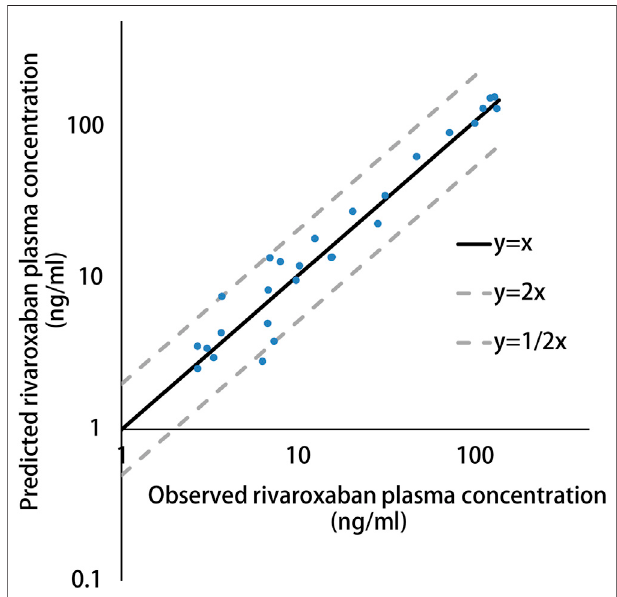
FIGURE 2 | Predicted versus observed plasma concentration of rivaroxaban in present patient cases.